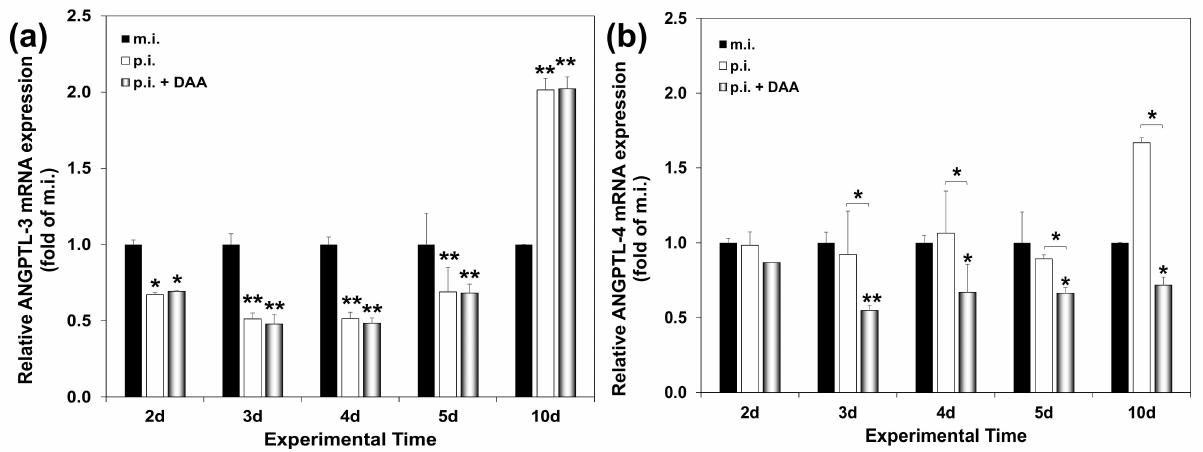
Figure 5. mRNA expression levels of ANGPTL-3 and ANGPTL-4 before and after HCV eradication in an in vitro HCV clearance model. Huh7.5 hepatoma cells infected with HCV-3a were harvested at the stated time points p.i. and subjected to RT-qPCR with ( a ) ANGPTL-3- or ( b ) ANGPTL-4-specific oligonucleotide primers. White and grey bins represent the ratio of relative mRNA expression in HCV-infected (p.i.) or HCV-cured (p.i. + DAA) cells to that of the mock-infected (m.i.) control (black bins). Statistically significant differences within groups are denoted by one star ( p -value ≤ 0.05), or two stars ( p -value ≤